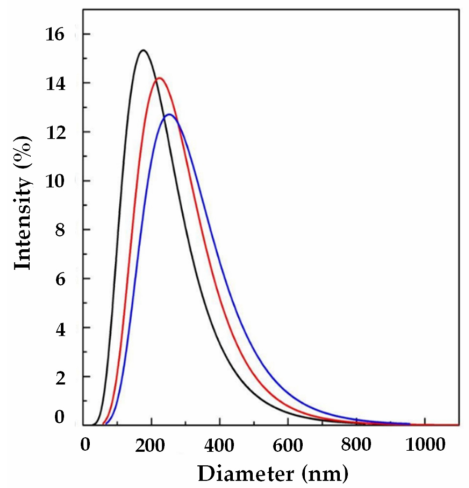
Figure 4. LSD by intensity at different Ab/Lipids in the presence of WFR fixed at 10 mL/min: ( ) 0.625, ( ) 1.25, and ( ) 2.50% ( w / w ). LSD: liposome size distribution, Ab/Lipids: antibody ‐ to ‐ lipid mass ratio, WFR: water flow rate.